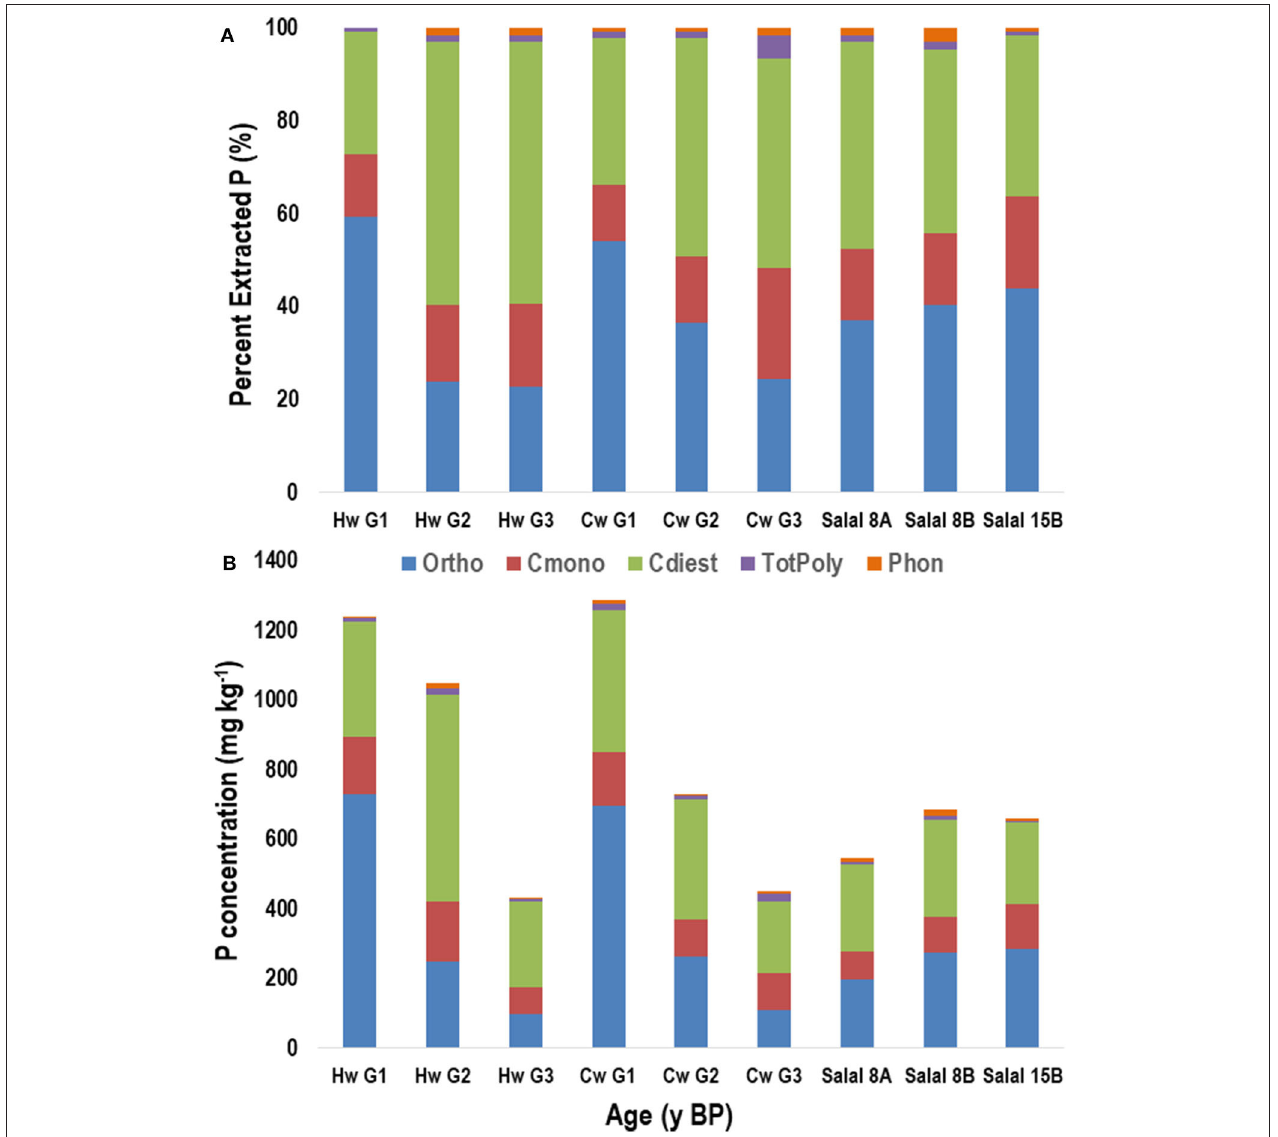
FIGURE 5 | Proportion (A) and concentration (B) of phosphorus (P) in NaOH-EDTA extracts analyzed by P-NMR of three foliage species from the Calvert Island, BC chronosequence: western hemlock (Hw), western redcedar (Cw) and salal by age groupings (G1, G2, G3) or by site (CIDS8A, 8B, 15B). Ortho, orthophosphate; Cmono, Cdi, orthophosphate monoesters and diesters corrected for degradation during analysis; totPoly, total polyphosphates; Phon, phosphonates. Age groupings were made based on soil total P concentrations with G1 representing ages ∼ 105 to ∼ 139 years, G2 representing ∼ 605 to ∼ 4,198 years and G3 representing ∼ 7,236 to ∼ 10,760